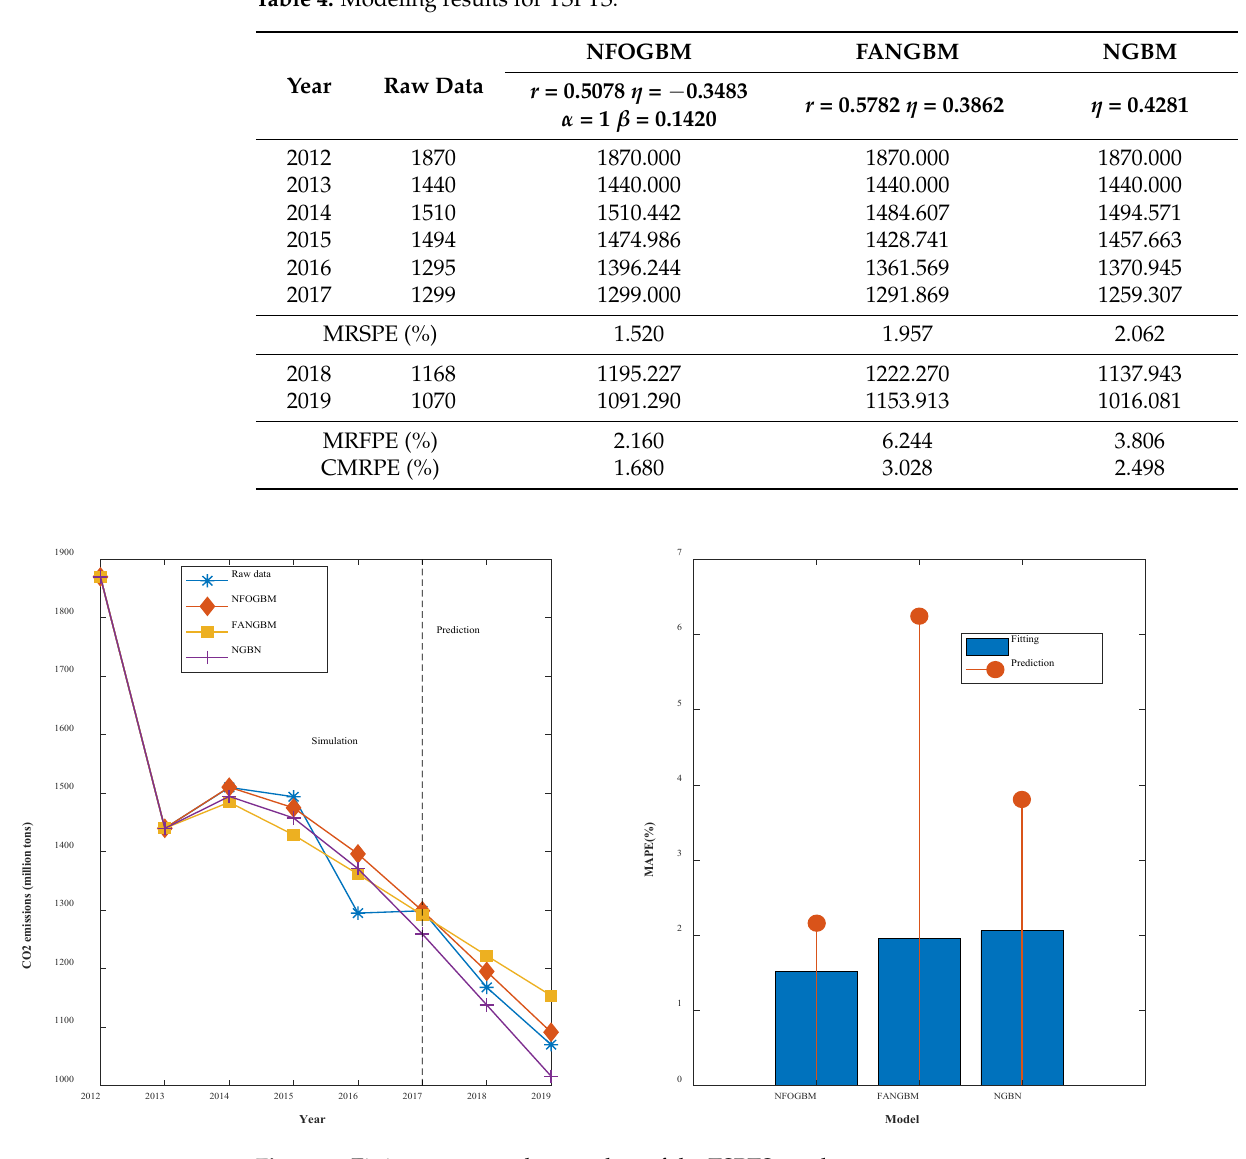
Table 4. Modeling results for TSPTS.